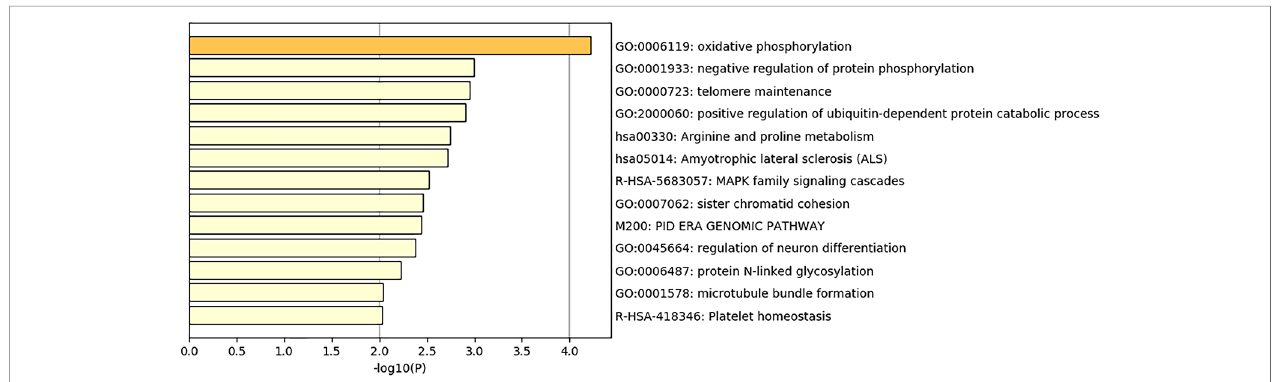
FIGURE 5 | Heatmap of top 13 clusters with their representative enriched